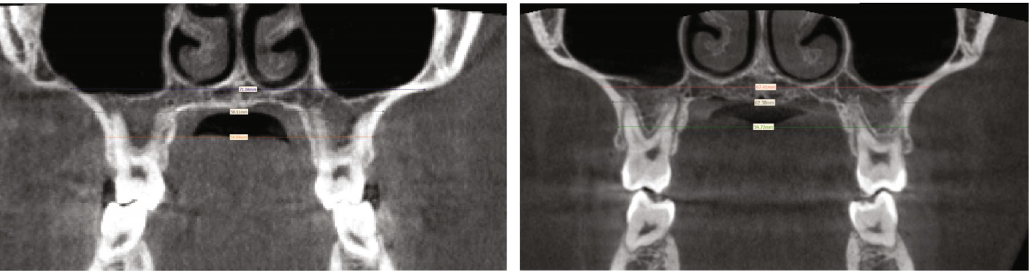
Figure 16: Expansion virtual evaluation.